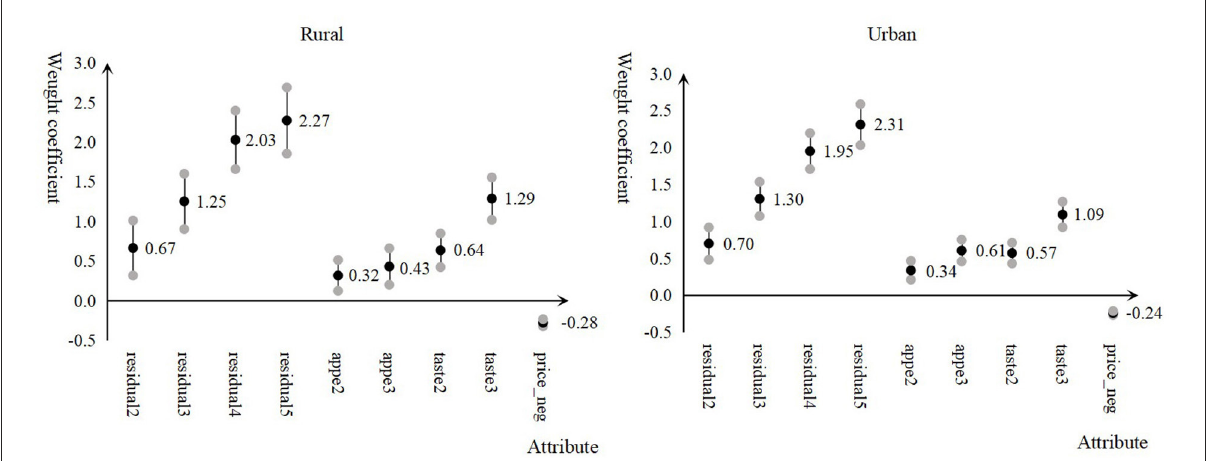
FIGURE1 Rural and urban consumer preference weights with a 95% CI.